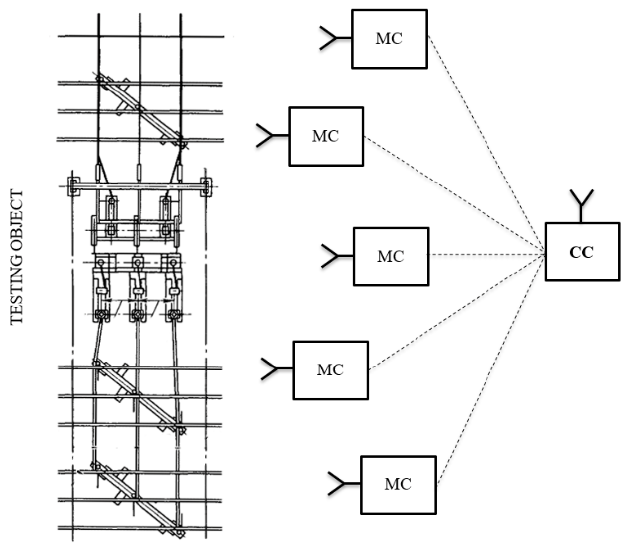
Figure 2. The monitoring system: MC—measuring cell, CC—the control center.